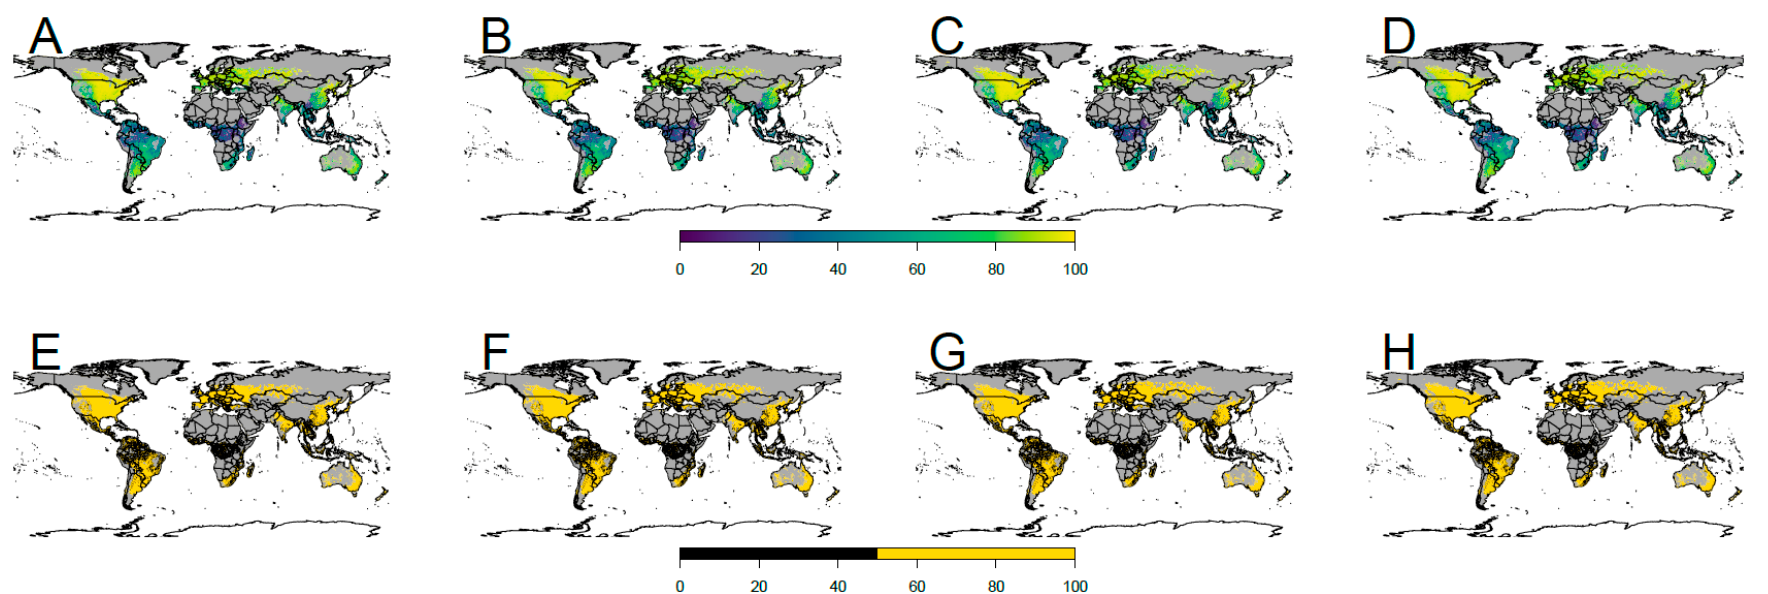
Figure 3. Distribution maps of the Japanese beetle estimated under future conditions (without accounting for species dispersal distance) derived using INLA SPDE. ( A – D ) yellow–blue scale indicates higher–lower occurrence probability values, respectively, ( E – H ) areas of predicted species occurrence estimated using a threshold value of 50.3 (threshold values estimated by maximizing TSS), presence shown in orange, while absence shown in black. Panels ( A , E ) refer to the future climatic scenario RCP 2.6, ( B , F ) to RCP 4.5, ( C , G ) to RCP 7, while ( D , H ) to RCP 8.5. Areas of uncertain prediction identified by mMESS, and those with DD values below the threshold of 711, are shown in grey.